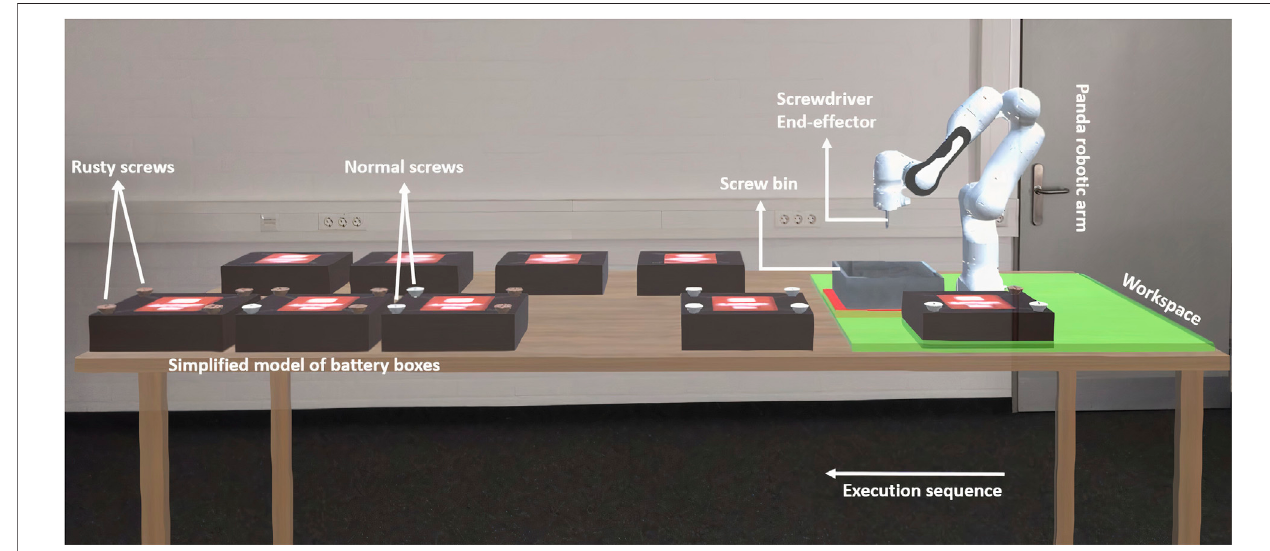
FIGURE 1 | Experiment setup (from participant ’ s point of view). The green area shows the accessible workspace of the robot. There are two rows of batteries: on the front side, the batteries with screws are located; on the back side, some extra already disassembled batteries are located to create a more realistic scene.